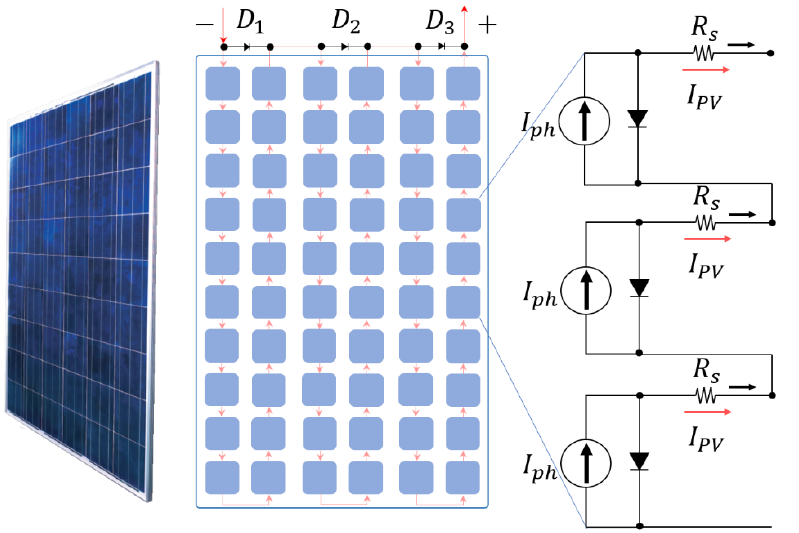
Figure 3. Current flow in PV cells and module. (All bypass diodes D 1 , D 2 , and D 3 are inactive). Theoretically, the R sh of a solar cell in a normal state is a very large value, and the current cannot flow elsewhere. In addition, Rs such as a cell that transmits electricity, an interconnector, and a silicon wafer that forms the cell, operates in an infinitely small state. The current equation for the PV module in the normal state is given by Equation (1). I Rsh is the current at shunt resistance.